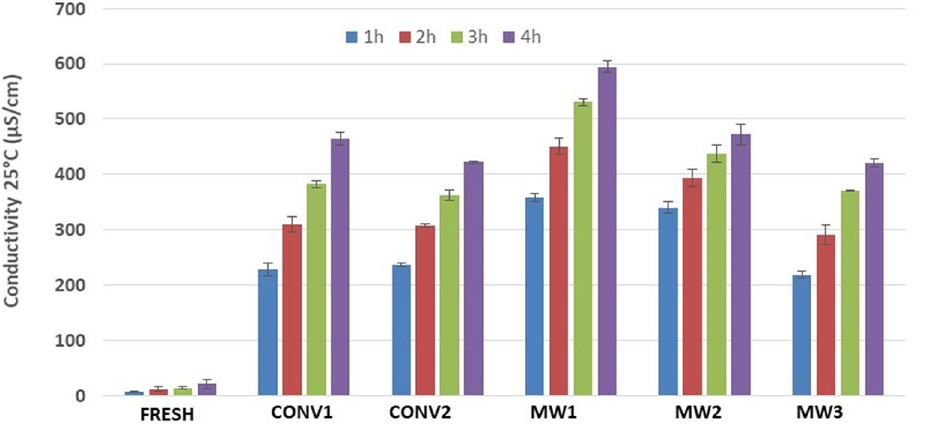
Figure 2. Electrolyte leakage from oregano samples (fresh and